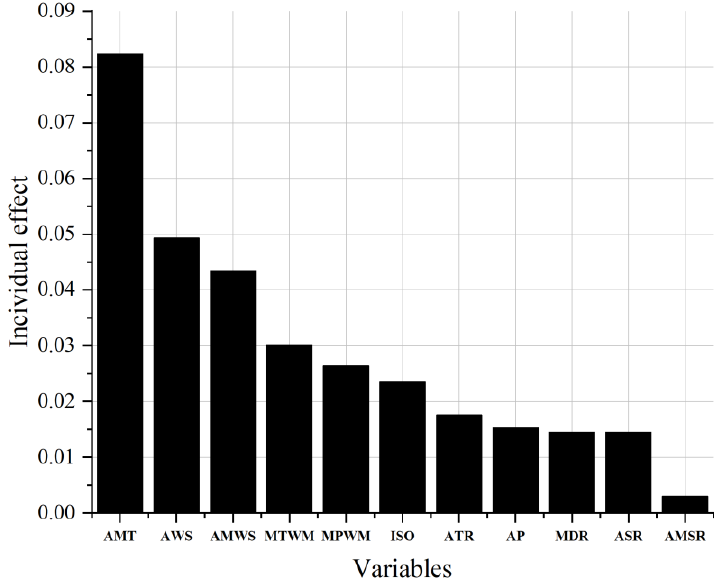
Figure 5. The relative importance of individual climate variables in predicting roof slope by rdacca.hp [38].